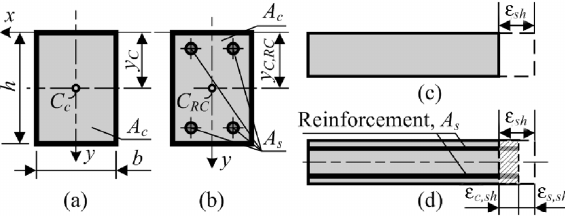
Fig. 5. Deformations of concrete and RC member due to shrinkage (Gribniak et al . 2007): a – plain concrete mem- ber; b – symmetrically reinforced section; c – free shrink- age deformation; d – deformations in a symmetrically re- inforced element due to restrained